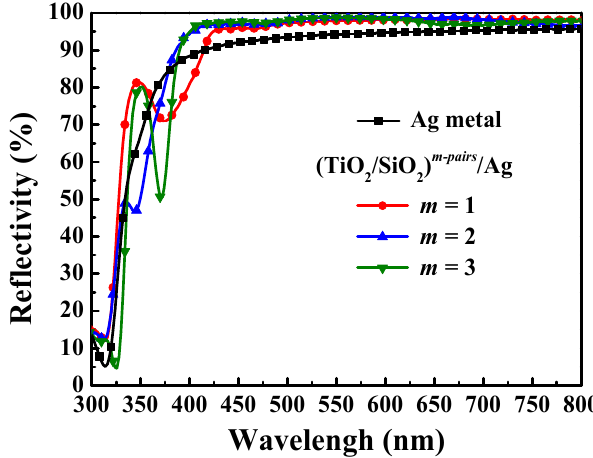
Figure 4. The reflectivity spectra of the Ag metal and (TiO 2 /SiO 2 ) m-pairs ( m = 1, 2, and 3)/Ag. In this work, the green and red QD color conversion layers were used to convert the blue light into the green and red lights, respectively. To avoid the red and green lights that emitted from the QDs/micro-LEDs blended with the non-absorbed blue light, the DBR with high reflectivity at the wavelength of 451 nm should be deposited on the red and green QDs color conversion layers.